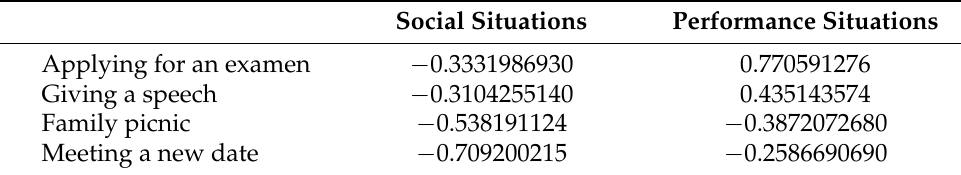
Table 9. Loading matrix C with the TuckerALS algorithm for behavioral level